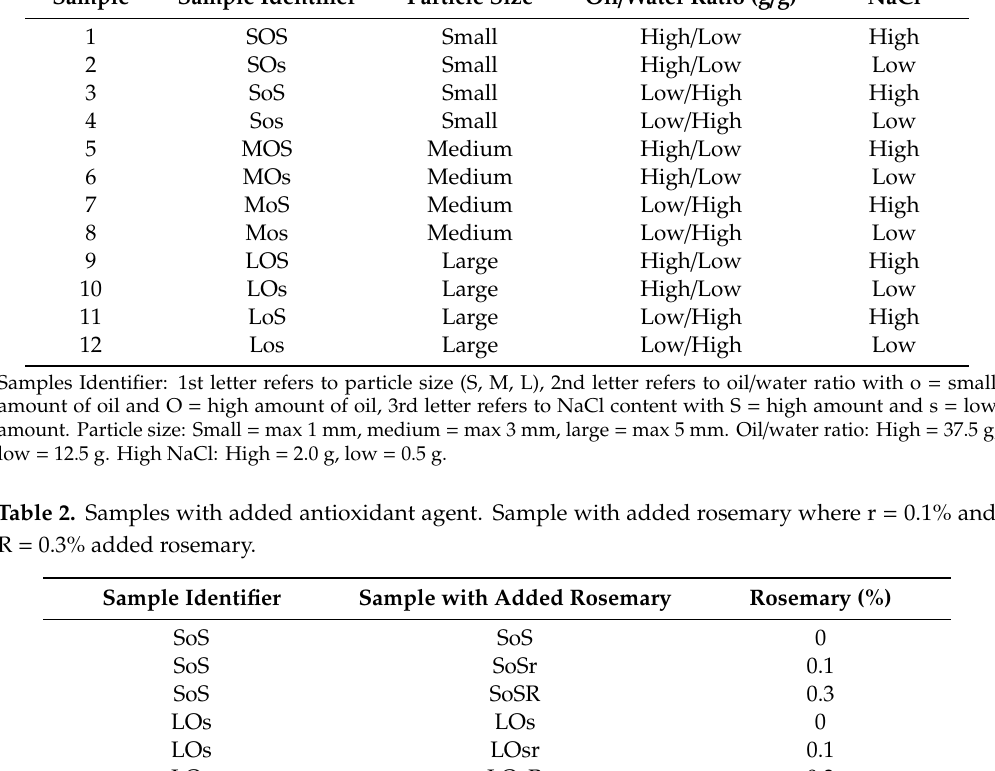
Table 1. Sample preparation with mealworm (50 g) particle size, oil / water ratio of 50 g mixture and NaCl contents.